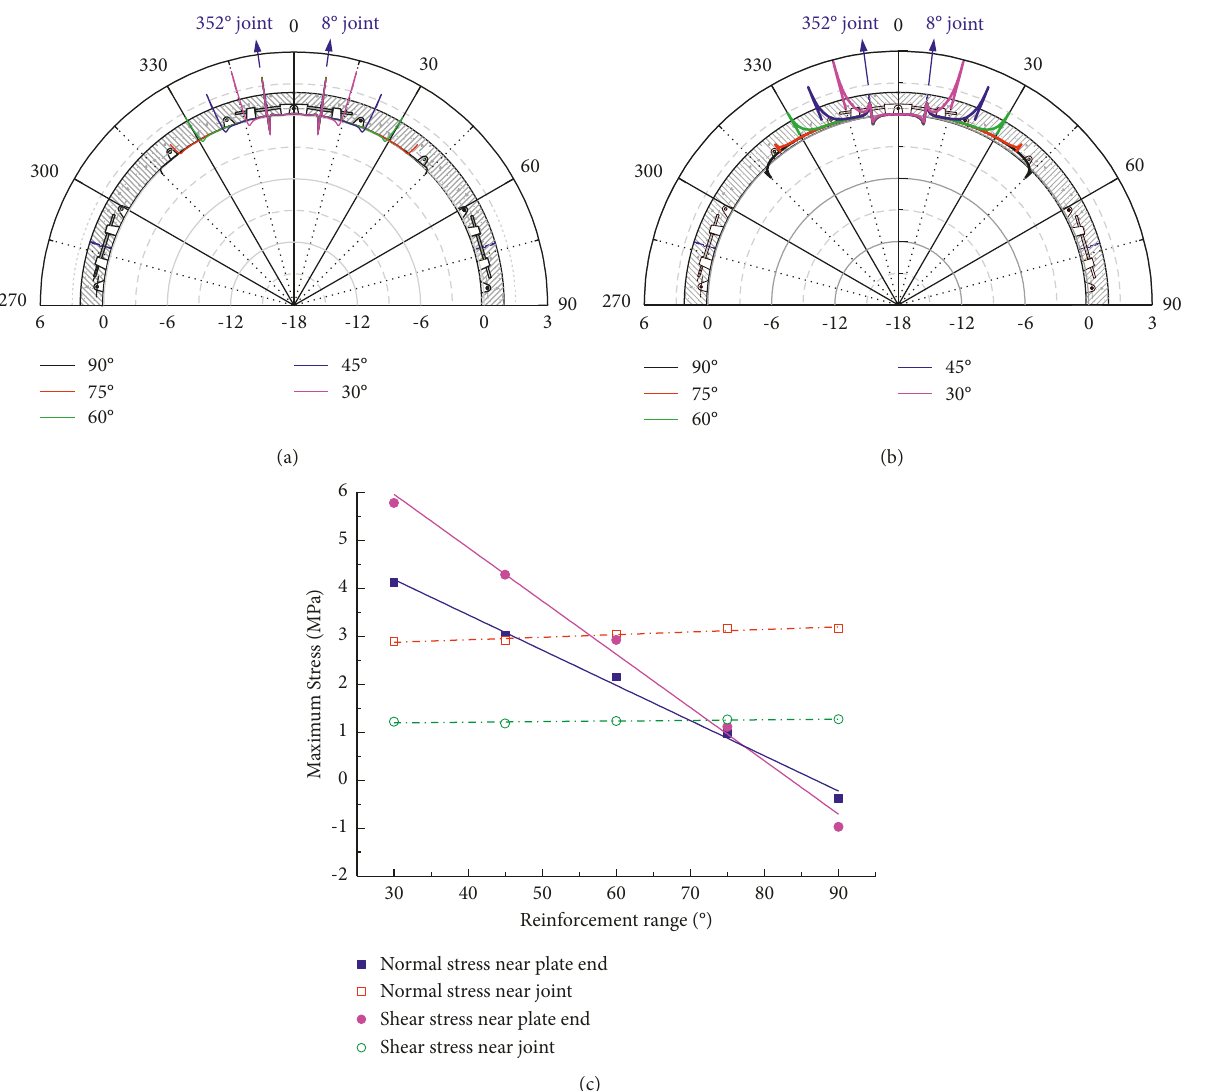
Figure 11: Interfacial stresses under different reinforcement ranges. (a) Normal stress. (b) Shear stress. (c) Relationship between maximum stress and reinforcement